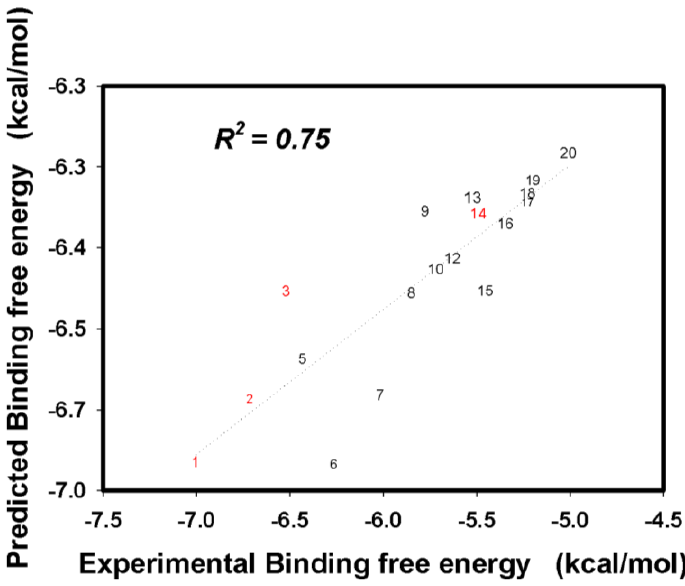
Figure 3. Predicted binding free energies versus experimentally determined binding free energies of the 20 inhibitors. The correlation constant ( R 2 ) is equal to 0.75. The inhibitors 1–3 and 14 (red) belong to the 2,3-dihydrobenzofuran backbone inhibitors and the others belong to the 5,7-dihydroxychromen-4-one backbone inhibitors